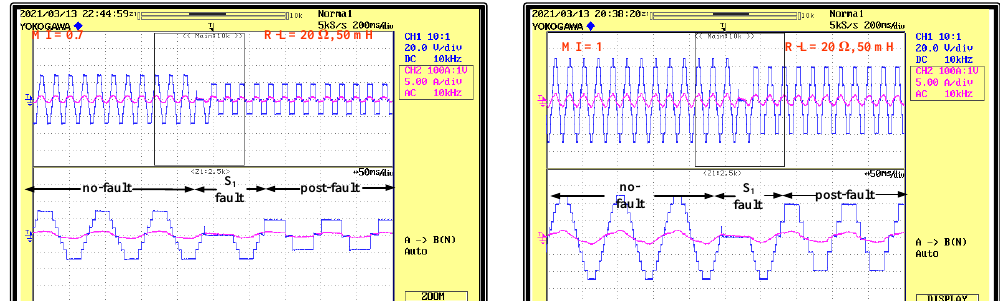
Figure 19. Experimental voltage and current waveforms under S 1 fault.